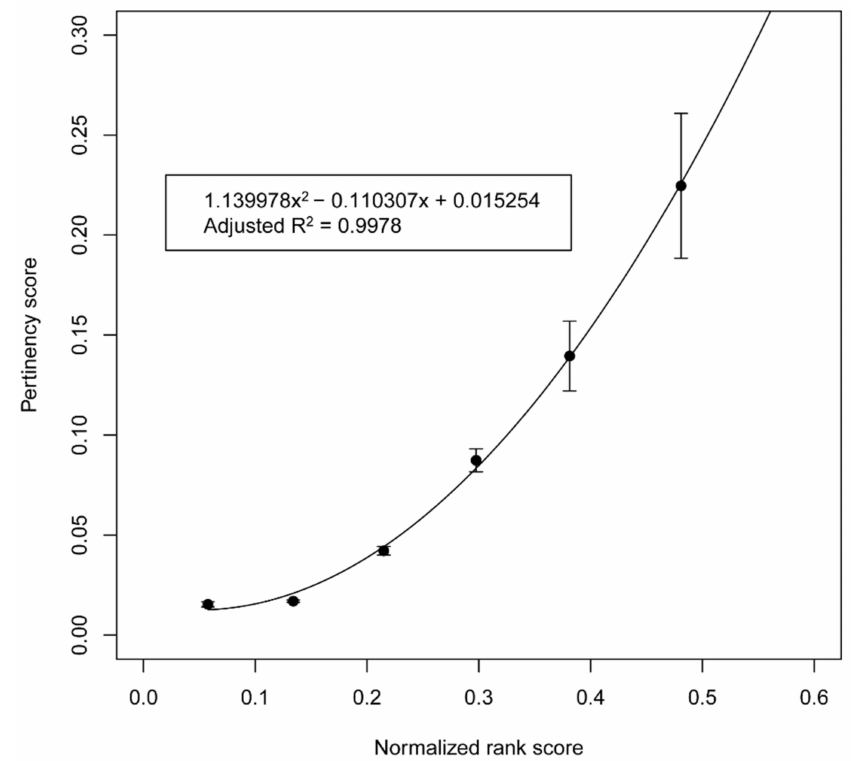
Figure 2. Plot of the pertinency scores versus priority scores. The priority scores of proteins in the protein–disease datasets were collected into six equally spaced intervals along the priority score range. The points on the ordinate of the plot are the means of the fractions of proteins that interact with medications currently known to treat the corresponding disease, termed the pertinency score, for the six folds of the validation set for each of the priority score intervals. The error bars are the standard errors of the means across the six folds. The curved black line indicates the fit using a weighted least squares regression with a second-order polynomial. The resulting equation is y = 1.399x 2 − 0.110x + 0.015, and the correlation coefficient is